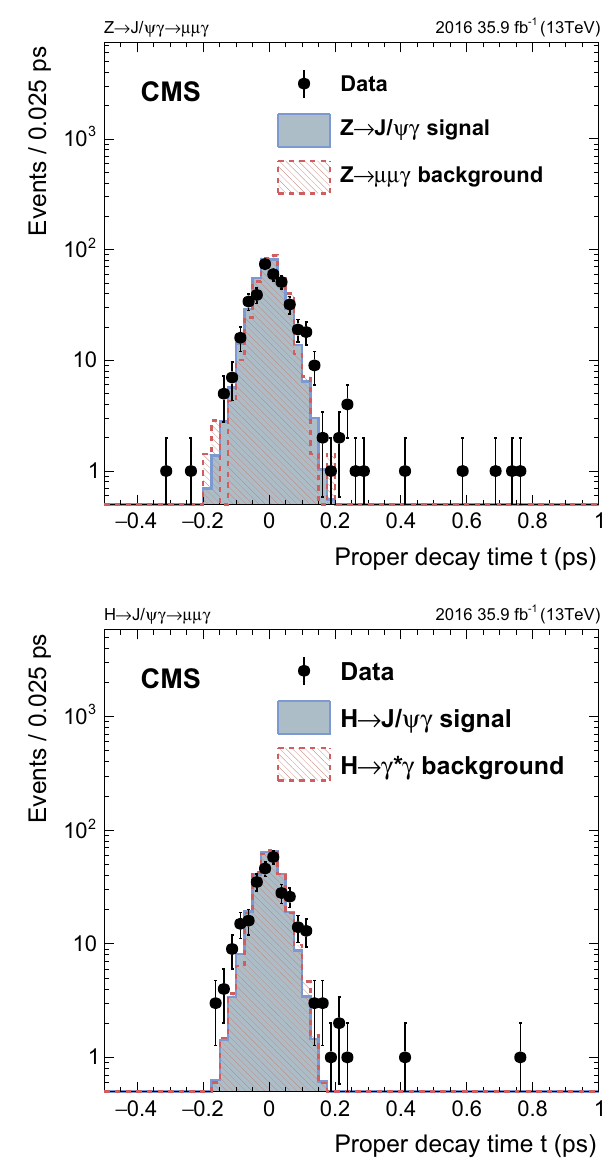
Fig. 6 The proper decay time, t, distributions in the Z (upper) and Higgs (lower) boson searches. Distributions in simulated events are normalized to the number of selected events in data. The distributions suggest that the J /ψ candidates reconstructed in data, just as signal events, are produced promptly at the pp interaction point, and not from displaced heavy-hadron decays